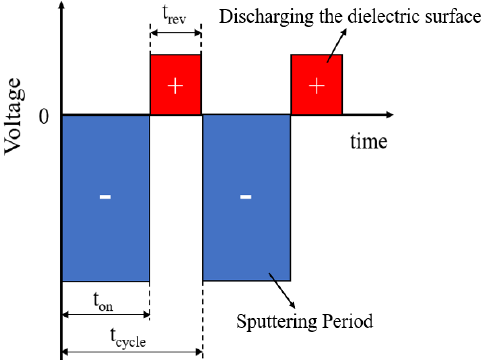
Figure 1. A typical pulsed DC sputtering pattern in an asymmetric bipolar voltage waveform.